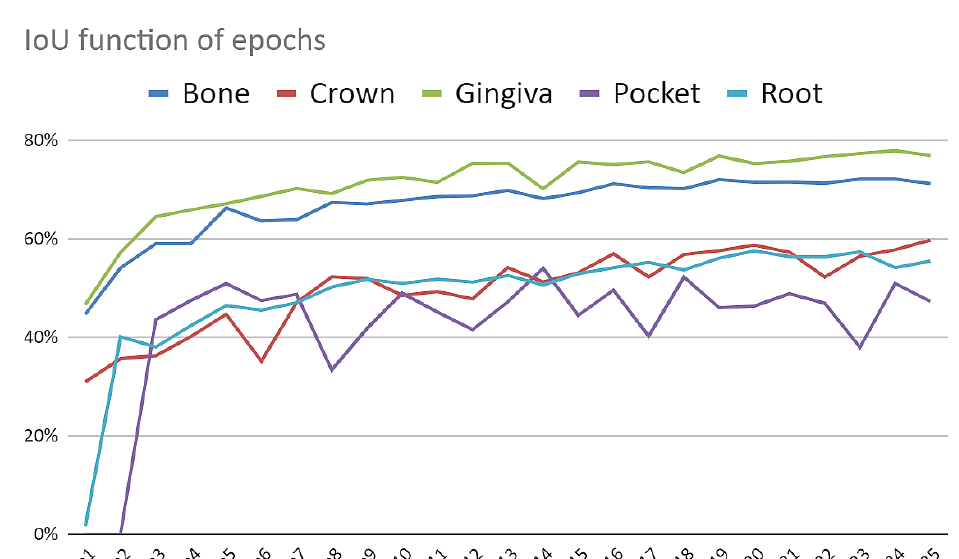
Figure 8. Mask R-CNN accuracy (IoU) as a function of number of epochs.